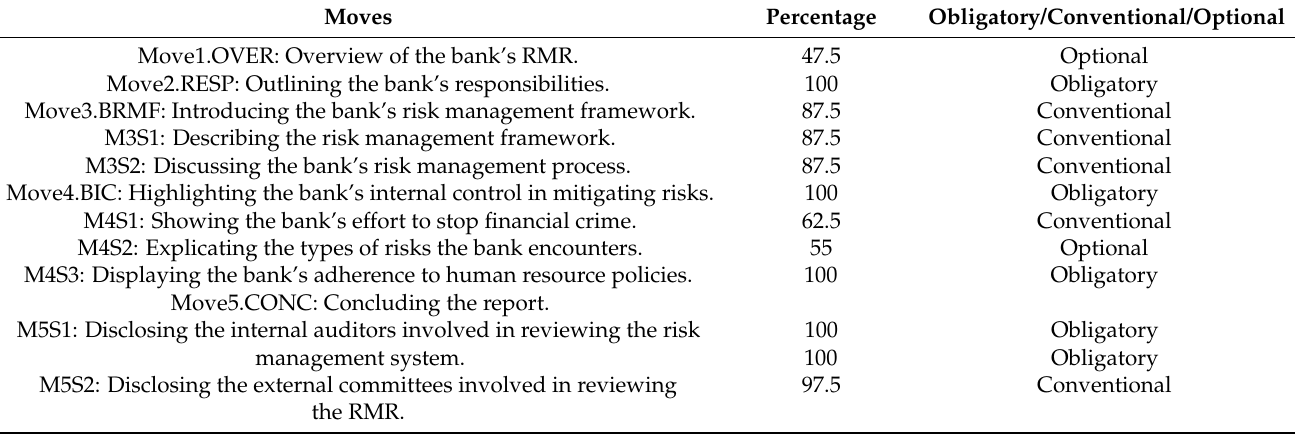
Table 1. Percentages of occurrences of moves and steps of RMRs by local commercial banks. Moves Percentage Obligatory/Conventional/Optional Move1.OVER: Overview of the bank’s RMR. 47.5